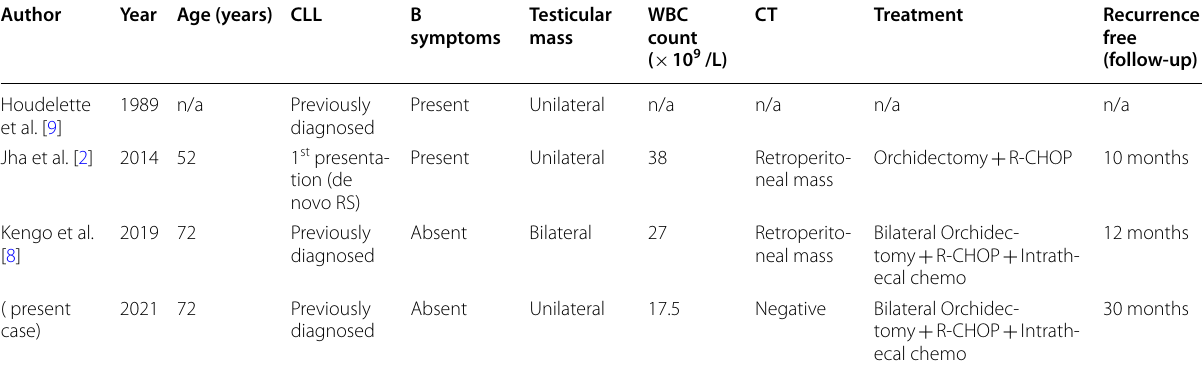
Table 1 Case reports of Richter’s syndrome presenting as testicular